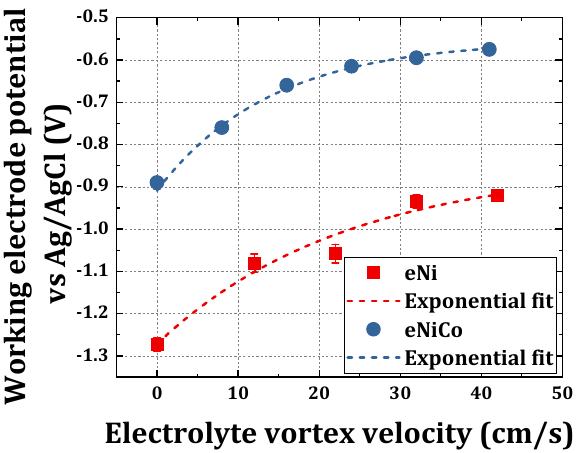
Figure 4. Working electrode potential E WE vs. Ag/AgCl reference electrode for j = 50 mA/cm 2 as a function of BHD with varying velocity recorded during the chronopotentiometric analysis for eNi and eNiCo alloys with cathode placed at x = 40 mm from vortex core, bath pH value of 4, temperature 45 °C, averaged over entire deposition time of 15 min (eNiCo alloys) and 60 min (eNi). For ECD without BHD, the potential 𝐸 (cid:3024)(cid:3006) required for the deposition of eNiCo al- loys is shifted by circa 400 mV compared to 𝐸 (cid:3024)(cid:3006) for given current density for eNi coat-